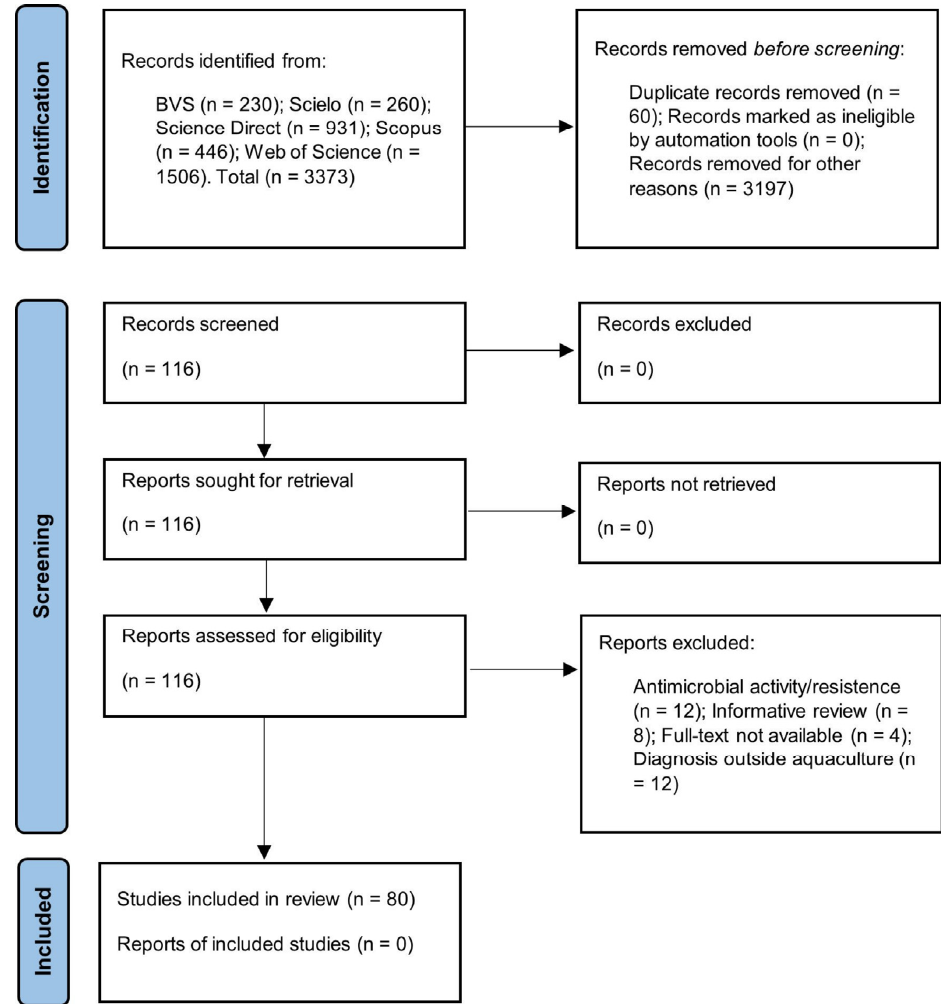
Figure 1. Strategy for the selection of eligible articles.